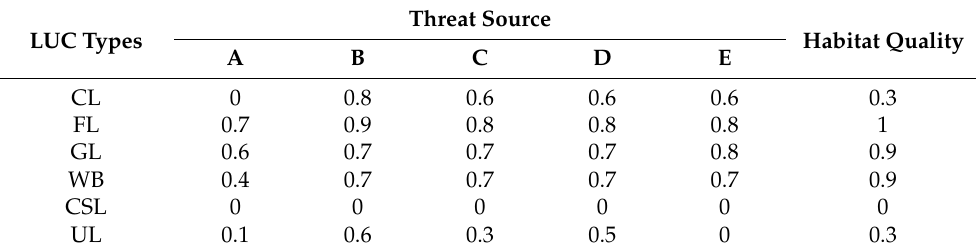
Table 4. Habitat suitability and sensitivity parameters for each LUC